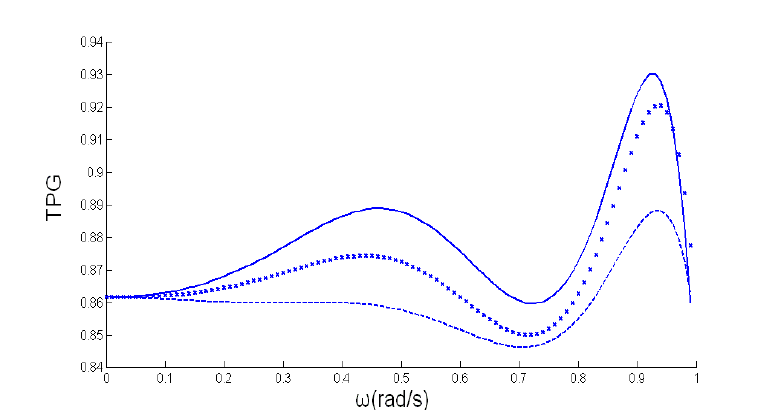
Figure 5. The TPG of the EIMNs: — GA; *RSE; ---